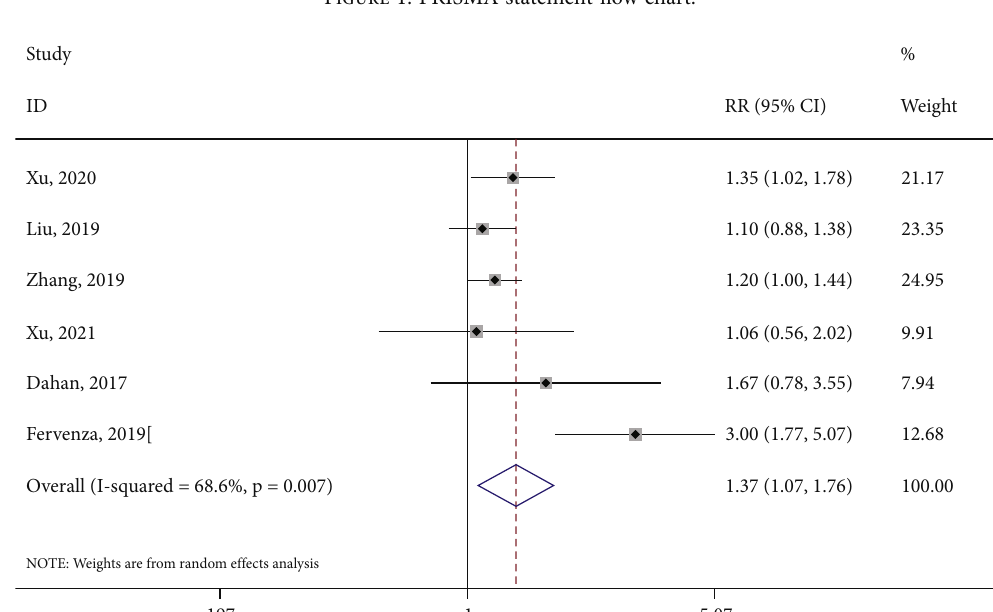
Figure 1: PRISMA statement fl ow chart.